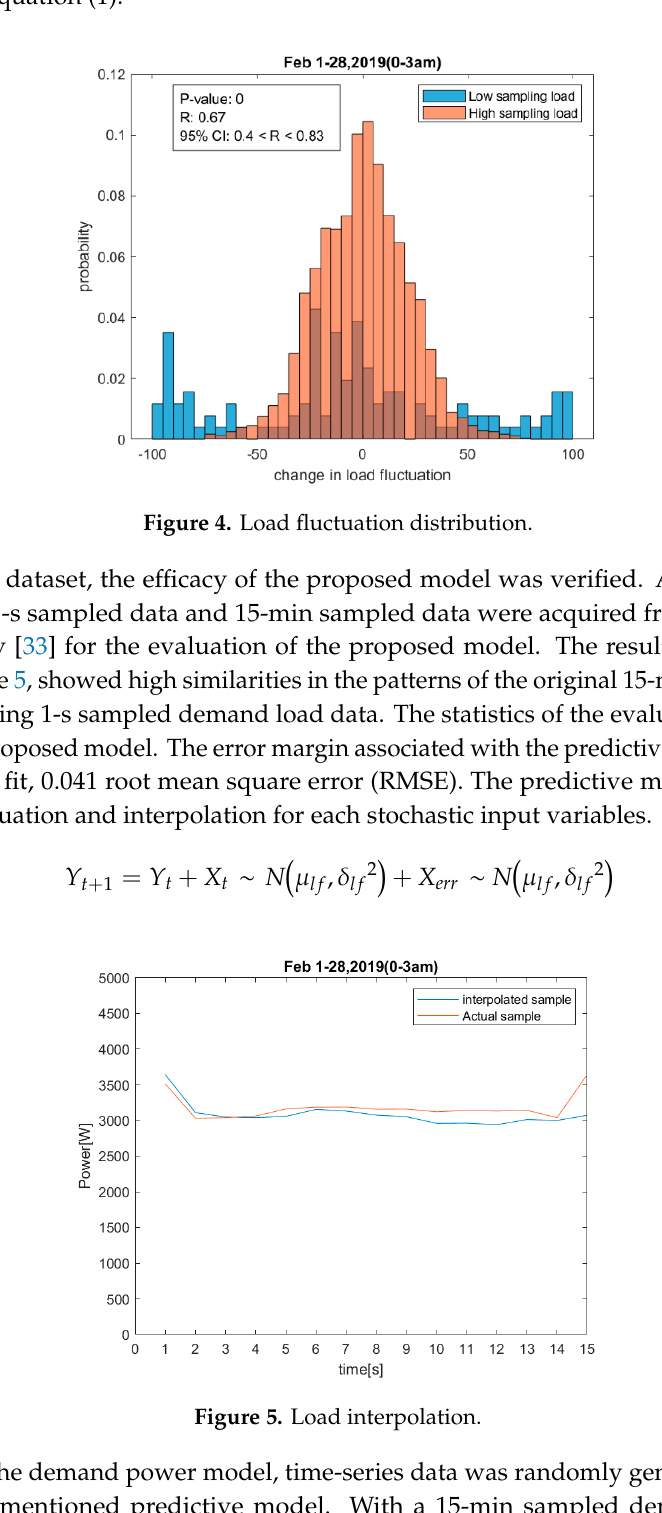
Figure 5. Load interpolation.